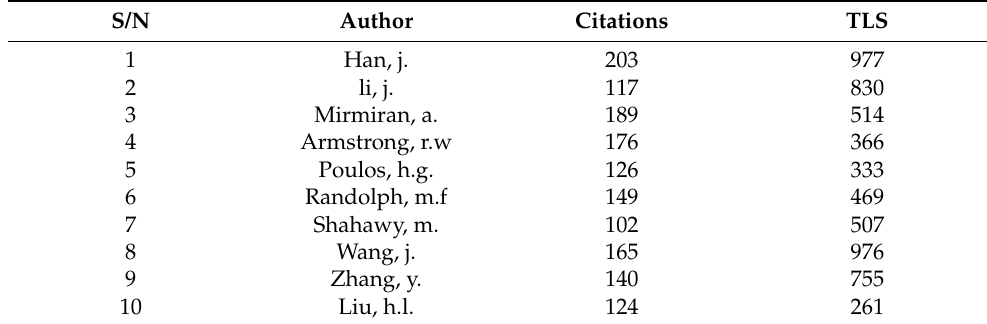
Table 3. Top authors and their Total Link Strengths are listed.